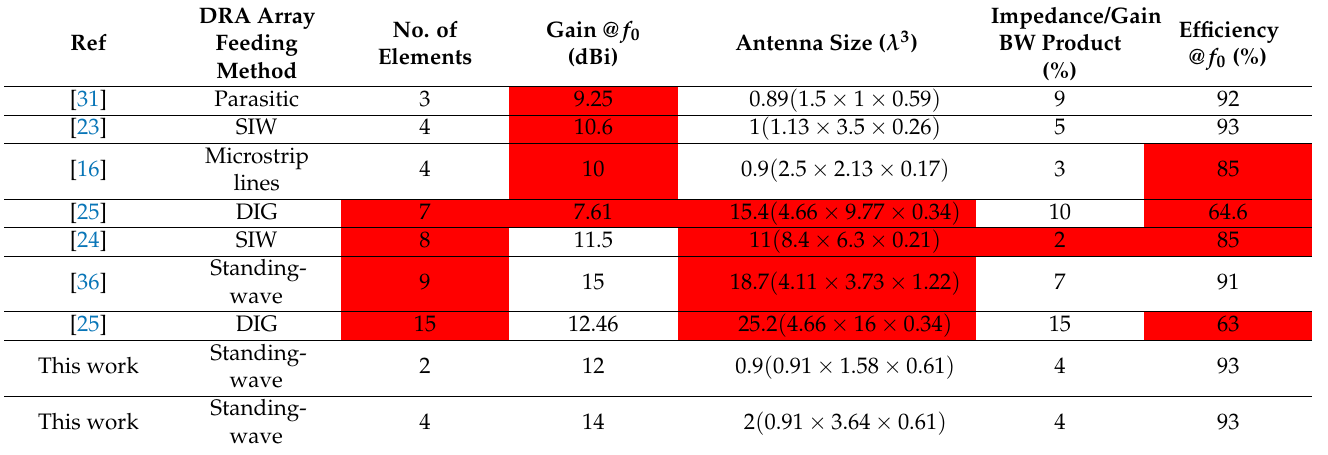
Table 2. Comparison of proposed standing-wave DRA array with arrays based on state-of-the-art feeding